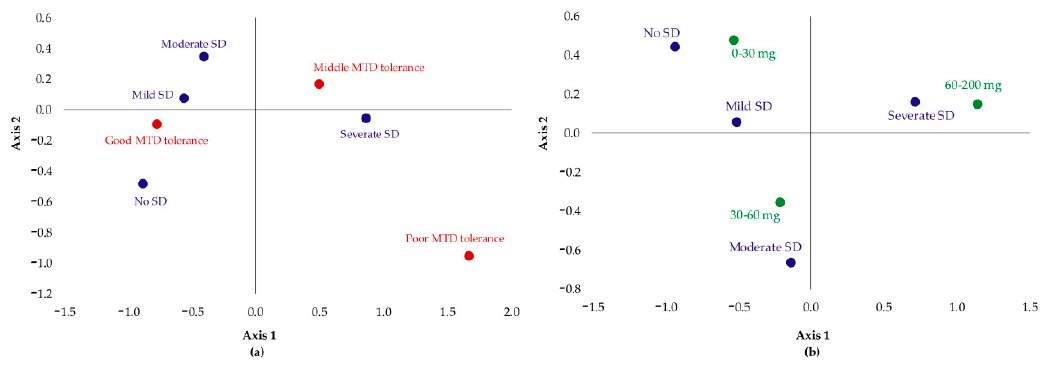
Figure 2. CFA graphical representations of the categories of two qualitative variables: ( a ) Tolerance to MTD (red) vs severity of SD (blue); ( b ) dose of MTD (green) vs severity of SD (blue).